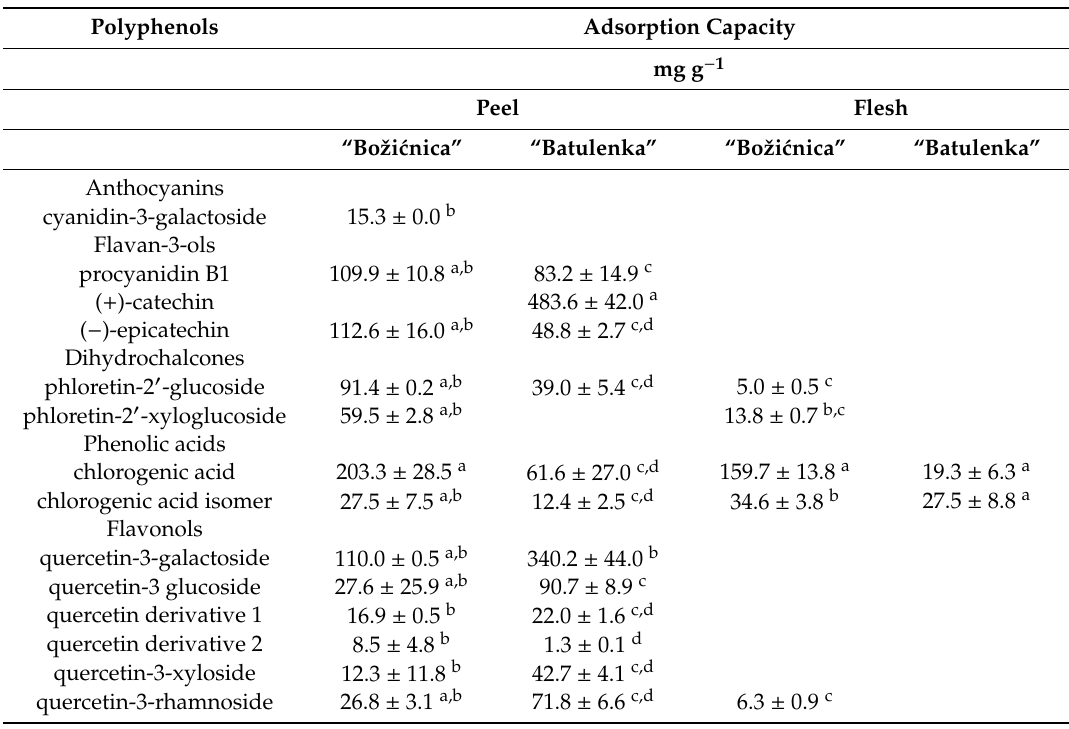
Table 1. Adsorption capacities* of β -glucan for polyphenols from peel and flesh of apples “Boži´cnica” and “Batulenka”.